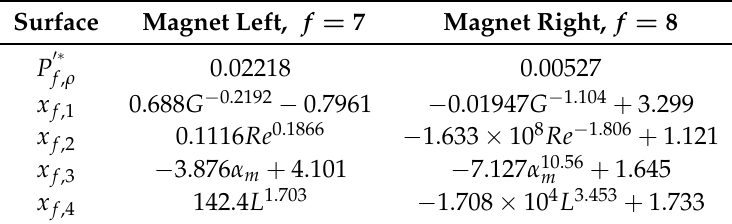
Table 2. Correlations to estimate the windage losses (W) due to pressure